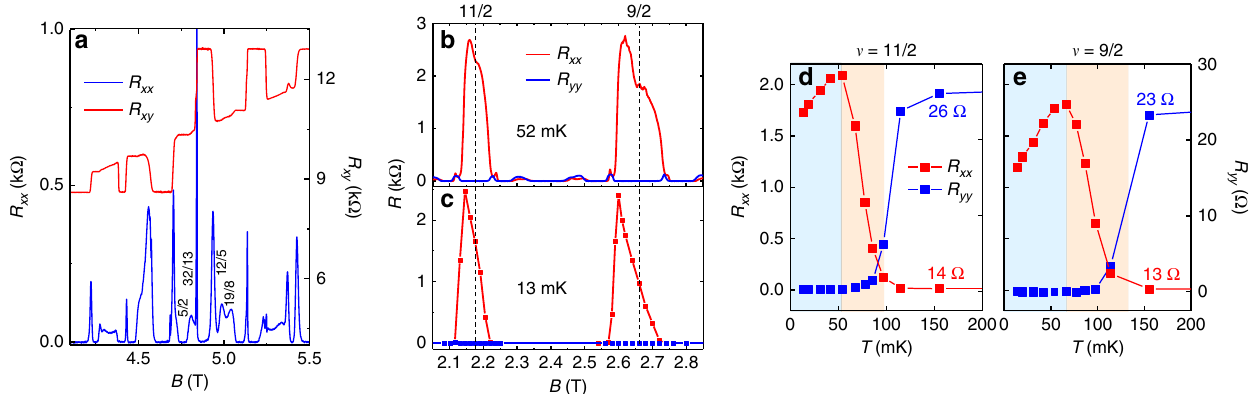
Fig. 2 Low temperature properties of Sample A. a Magnetotransport in the N = 1 LL from Sample A at T = 12 mK. The presence of FQHS at ν = 5/2 and 12/5 indicates the high quality of this sample. b N = 2 LL transport showing the anisotropic phases at ν = 11/2 and ν = 9/2 at T = 52 mK obtained by sweeping the magnetic fi eld; at this temperature no signi fi cant hysteresis or metastability occurs. c N = 2 LL transport at T = 13 mK. Each data point at this temperature was obtained by fi xing the magnetic fi eld and cooling from 200 mK down to 13 mK. R xx (red) is measured along the 110 GaAs lattice and R yy (blue) is measured along the 110 h i direction. Dashed lines indicate the positions of exact half- fi lling. d ν = 11/2 and e ν = 9/2 R xx (red) and R yy (blue) as a function of temperature taken at exactly half- fi lling factor for each state. The high temperature values of R xx and R yy are labeled. The colors of the regions indicate the different phases: isotropic liquid (white), nematic liquid crystal (pink), and smectic liquid crystal (blue)